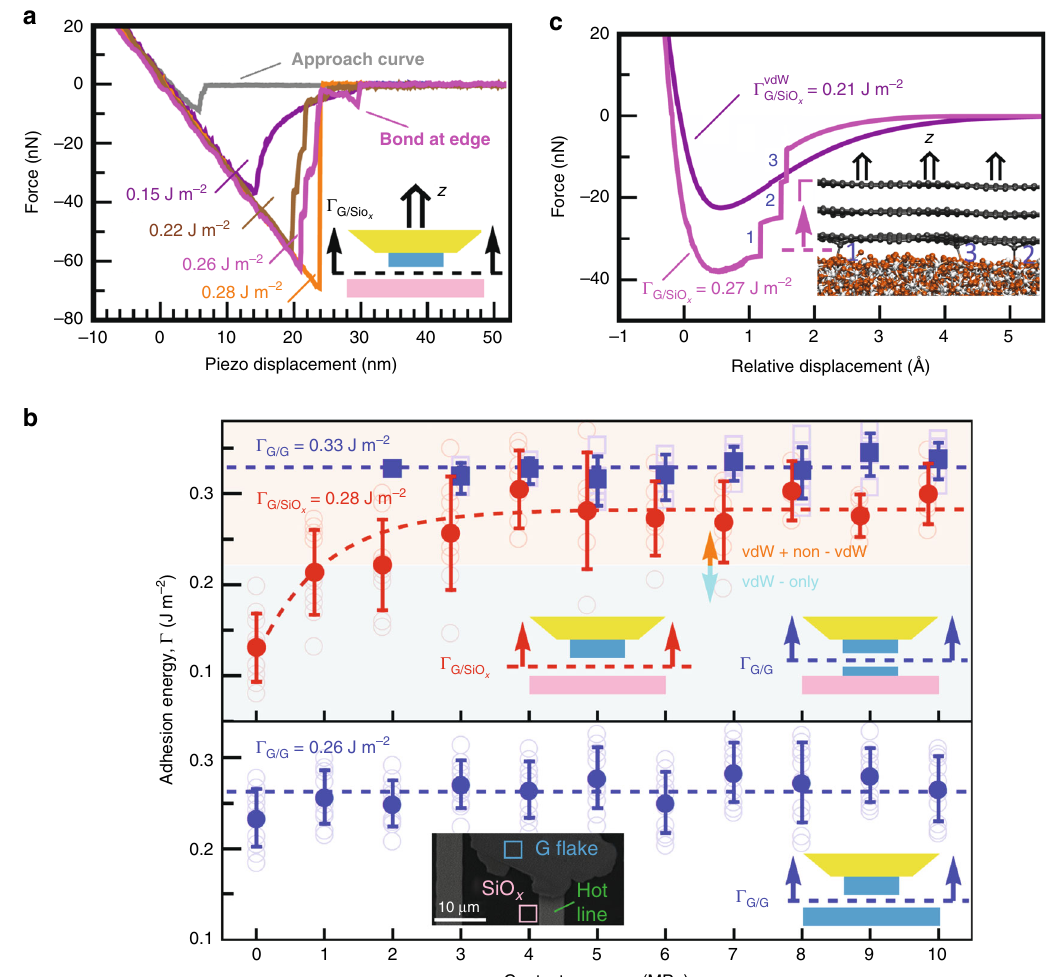
Fig. 3 Interaction mechanism at G/SiO x heterointerface. a Typical retraction F – d curves of the G/SiO x interface recorded at no contact pressure (in purple) and 5 MPa (in brown, magenta and orange) and also a typical approach F – d curve (in gray). b IAE values as a function of contact pressure at the intact G homointerfaces ( fi lled blue squares in top panel), G/SiO x interfaces ( fi lled red circles in top panel), and aged G homointerfaces ( fi lled blue circles in bottom panel). Each open transparent symbol represents a single IAE measurement at the given contact pressure. Each fi lled symbol is presented as average of all corresponding open symbols± standard deviation. From 110 IAE measurements shown in the top panel, 33 and 77 contacts result in the separation of G crystal tip across the thickness of the nanomesa (open blue squares) and from the SiO x surface (open red circles), respectively. In the top panel, cyan and orange shaded regions indicate the vdW-only and vdW + non-vdW interactions of G/SiO x , respectively, where the lift-off in the vdW-only region is relatively gradual in comparison to the vdW + non-vdW region. Dashed blue lines denote an overall average IAE value of 0.328 ± 0.022 and 0.263 ± 0.032 J m − 2 at the intact G homointerface (top panel) and aged G homointerface (bottom panel), respectively. Dashed red line in the top panel represents the best fi t to the data, indicating the pressure dependence of IAE at the interface with an average value of 0.284 ± 0.046 J m − 2 taken within the pressure-independent region (i.e., ≥ 3 MPa). Inset of bottom panel: SEM image showing 2 μ m × 2 μ m square regions of G (in turquoise) and SiO x (in rose) substrates on which all measurements are performed in close proximity to the microheater. c MD-calculated force versus relative displacement curves for the vdW-only interaction of G/SiO x (in purple) and vdW + non-vdW interaction of G/SiO x (in magenta) with three covalent C – O – Si bonds at the interface. Each force jump labeled by 1, 2, and 3 represents the break of the corresponding covalent bond, as illustrated by the MD pull-off simulation in the to the silanol groups) and liquid-like few-layer structure on top of the ice-like layer at room temperature. Such trapped liquid-like fi lm can segregate into isolated nano-sized bubbles 31 by means of the contact pressure and the interlayer vdW forces, bringing the 2D crystals into closer proximity with the SiO x surface and thus enhancing the IAE at the 2D crystal/SiO x interface. We also note that the thermal annealing at 130 and 300 °C makes no appre- ciable difference in the interfacial adhesion level between 2D crystal/precooling-treated SiO x and 2D crystal/untreated SiO x , con fi rming the formation of the protective ice-like layer on the untreated SiO x substrate due to 15% RH in the ambient air. partial etching of the MoS 2 interface layer and needle-like